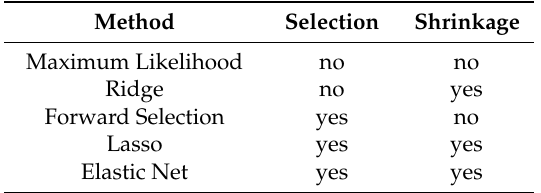
Table 3. Penalization methods versus selection and shrinkage.